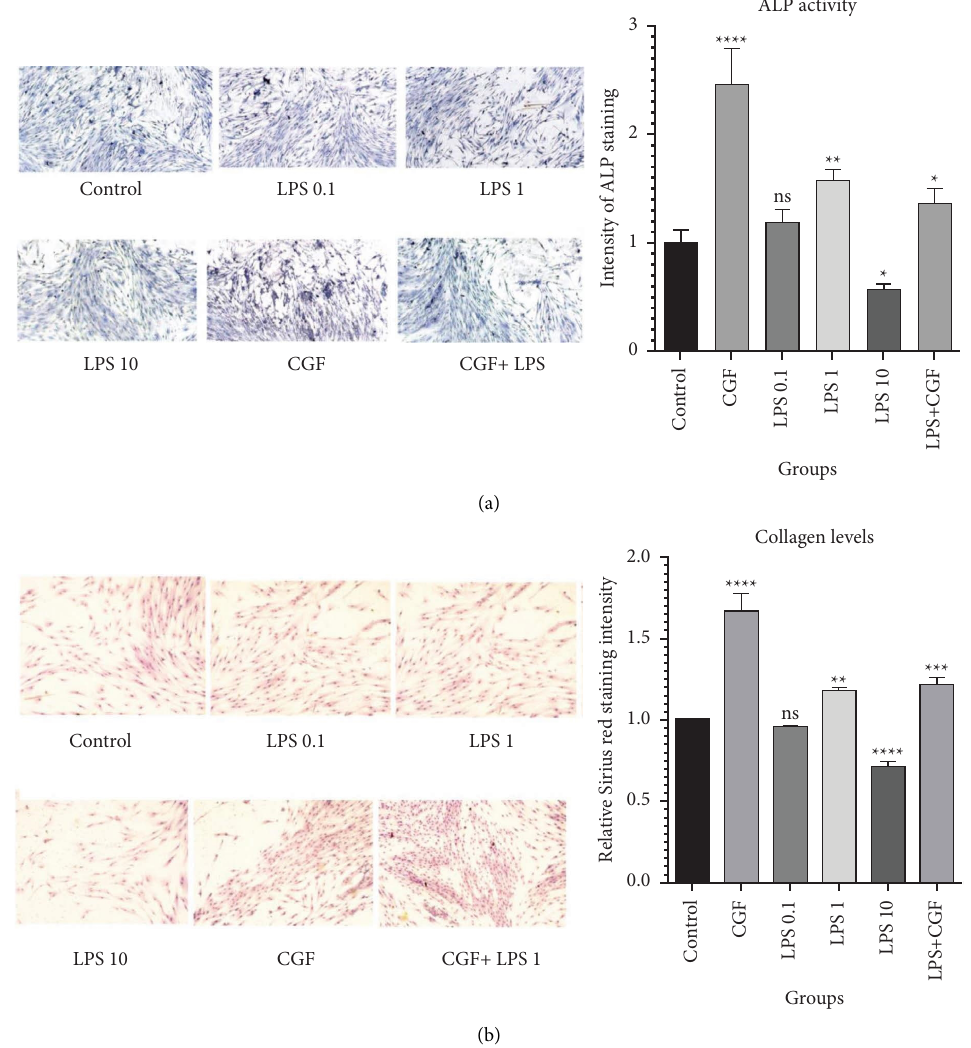
Figure 6: Osteogenic simulation in treatment groups. (a) ALP staining assay; concentrated growth factor (CGF) and lipopolysaccharide (LPS) 1 µ g/ml, separately or alone, induced alkaline phosphatase (ALP) activity in dental pulp stem cells (DPSCs). (b) Sirius Red staining assay showing higher levels of collagen in the LPS 1 µ g/ml, CGF, and CGF+LPS 1 µ g/ml groups; ∗∗∗∗ p < 0 . 0001 , ∗∗∗ p < 0 . 001 , ∗∗ p < 0 . 01 , ∗ p < 0 . 05 and ns �